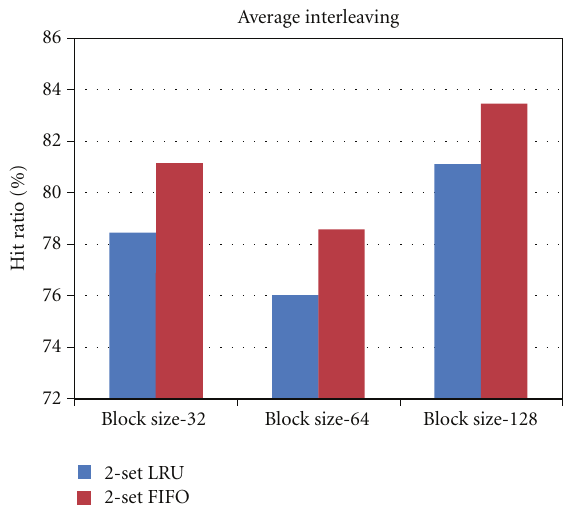
Figure 14: Hit ratio of replacement policy comparison—average interleaving.